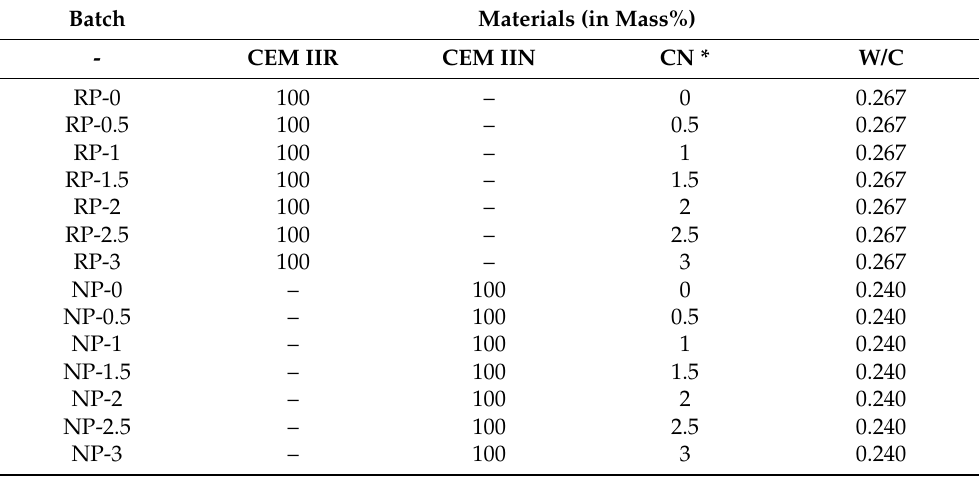
Table 3. Compositions of fresh cement pastes for investigating viscosity and setting times.